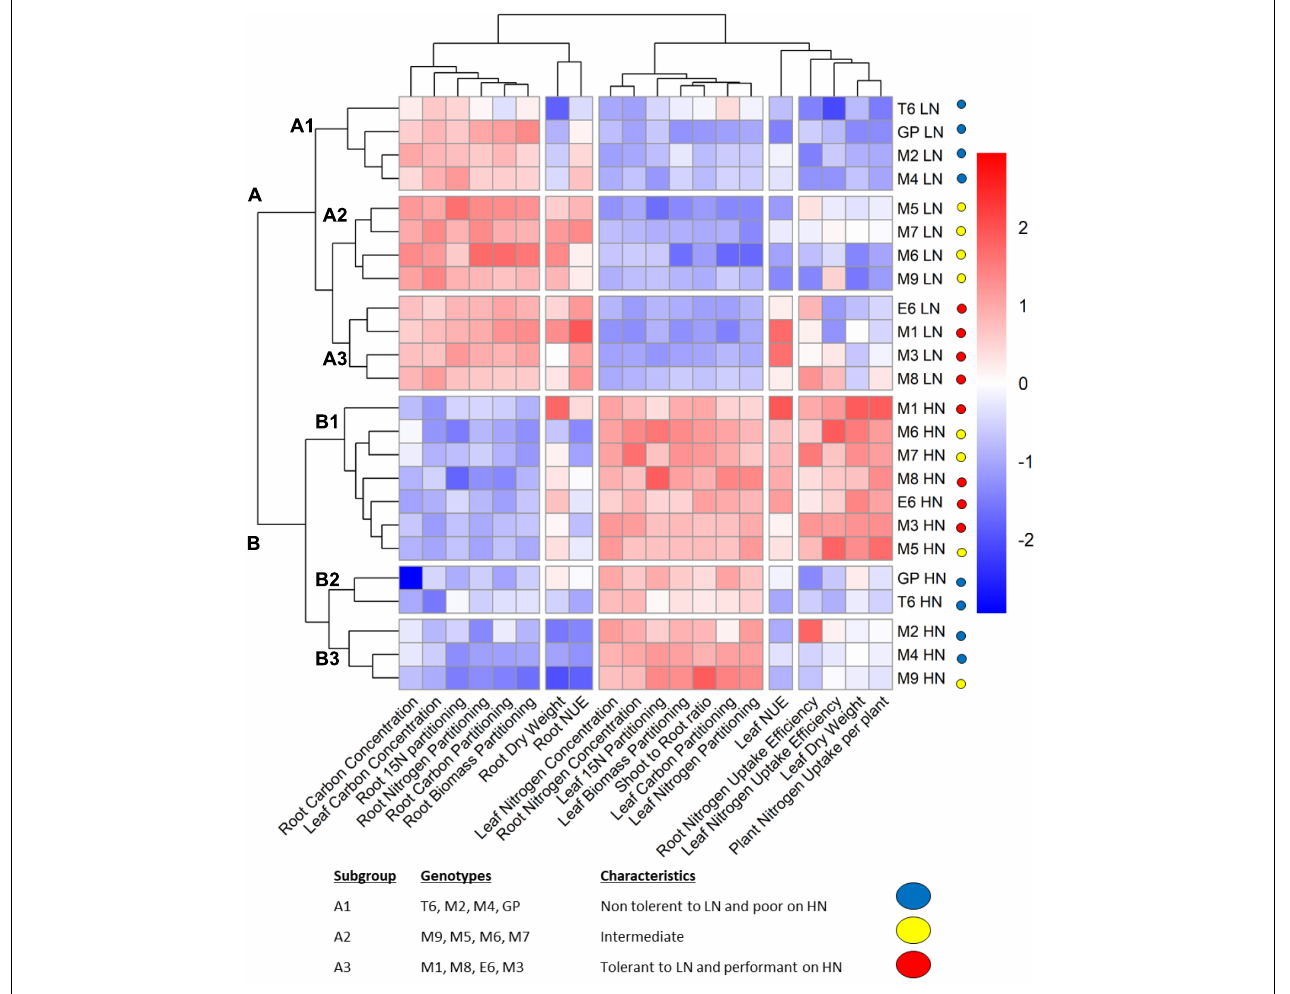
FIGURE 2 | Hierarchical clustering analysis (HCA) showing groups of genotypes sharing similar physiological traits. Plants were grown for 14 days under LN or HN then leaves and roots were harvested separately and frozen under liquid nitrogen. The physiological parameters were measured as indicated in the “Materials and Methods” section. The color scale is based on the value of the normalized mean for each trait. Normalization was made for the LN and HN conditions separately. The clustering under LN was chosen to determine three subgroups (A1, A2, and A3) labeled with the indicated colors. HCA was constructed with the R